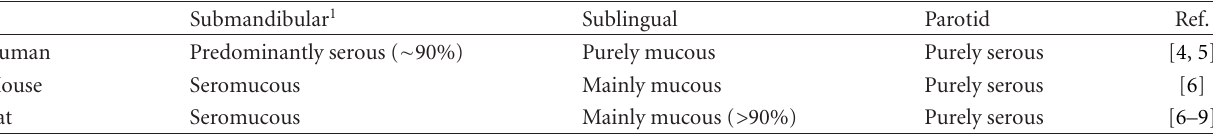
Table 1: Acinar cell type of the major salivary